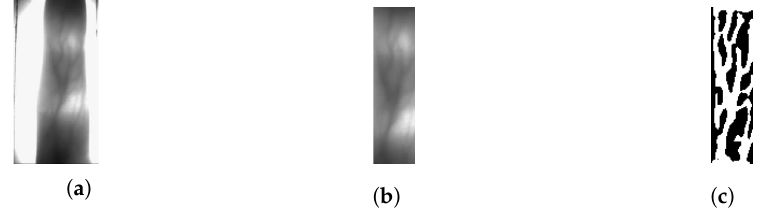
Figure 6. Finger-vein image samples collected in ( a ) first session and ( b ) second session.